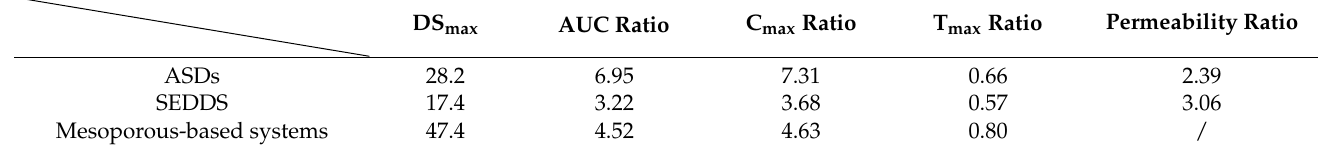
Table 2. Comparison of the enhancement effect among different